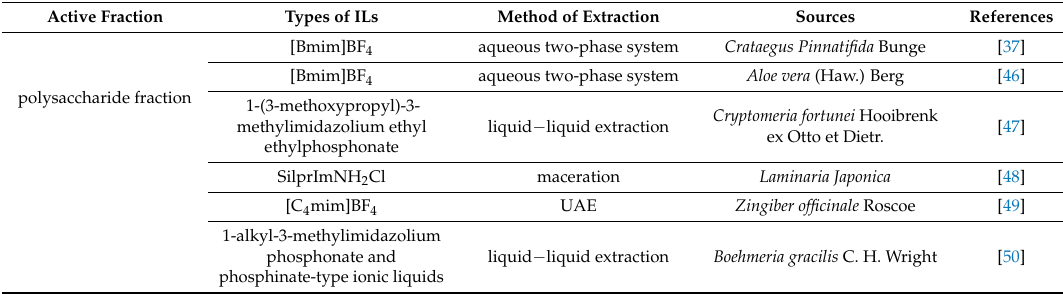
Table 3. The application of ILs on extraction of polysaccharides